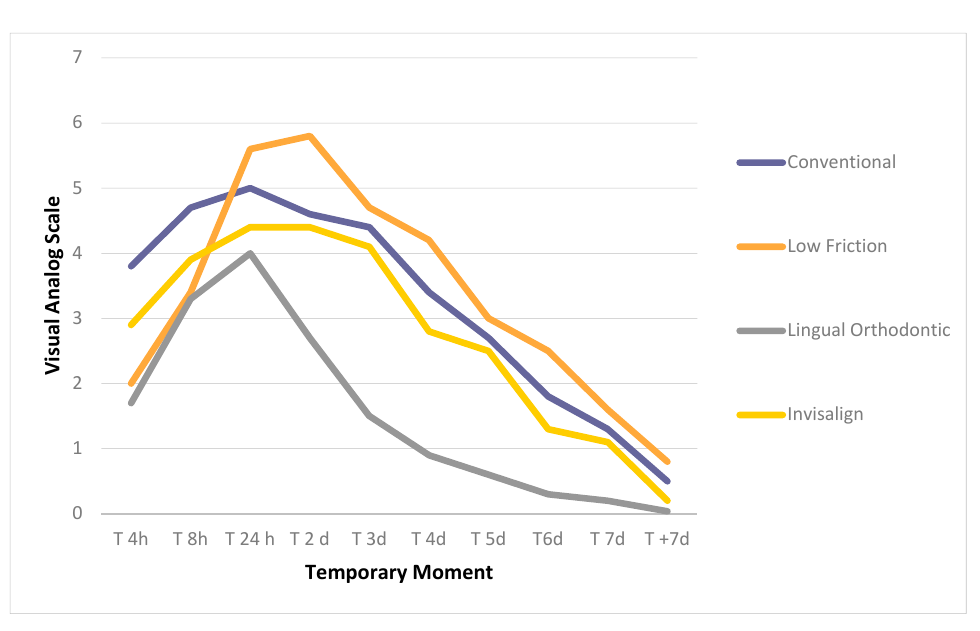
Figure 1. Pain analysis according to the visual analog scale (VAS).